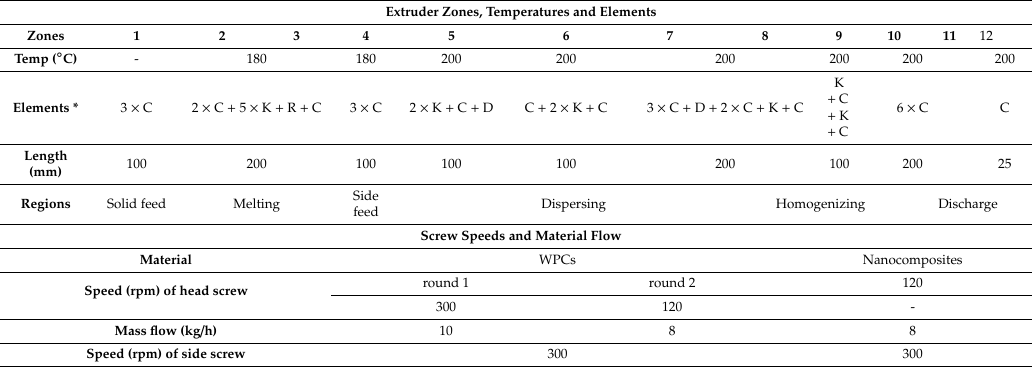
Table 1. Parameters of the extrusion